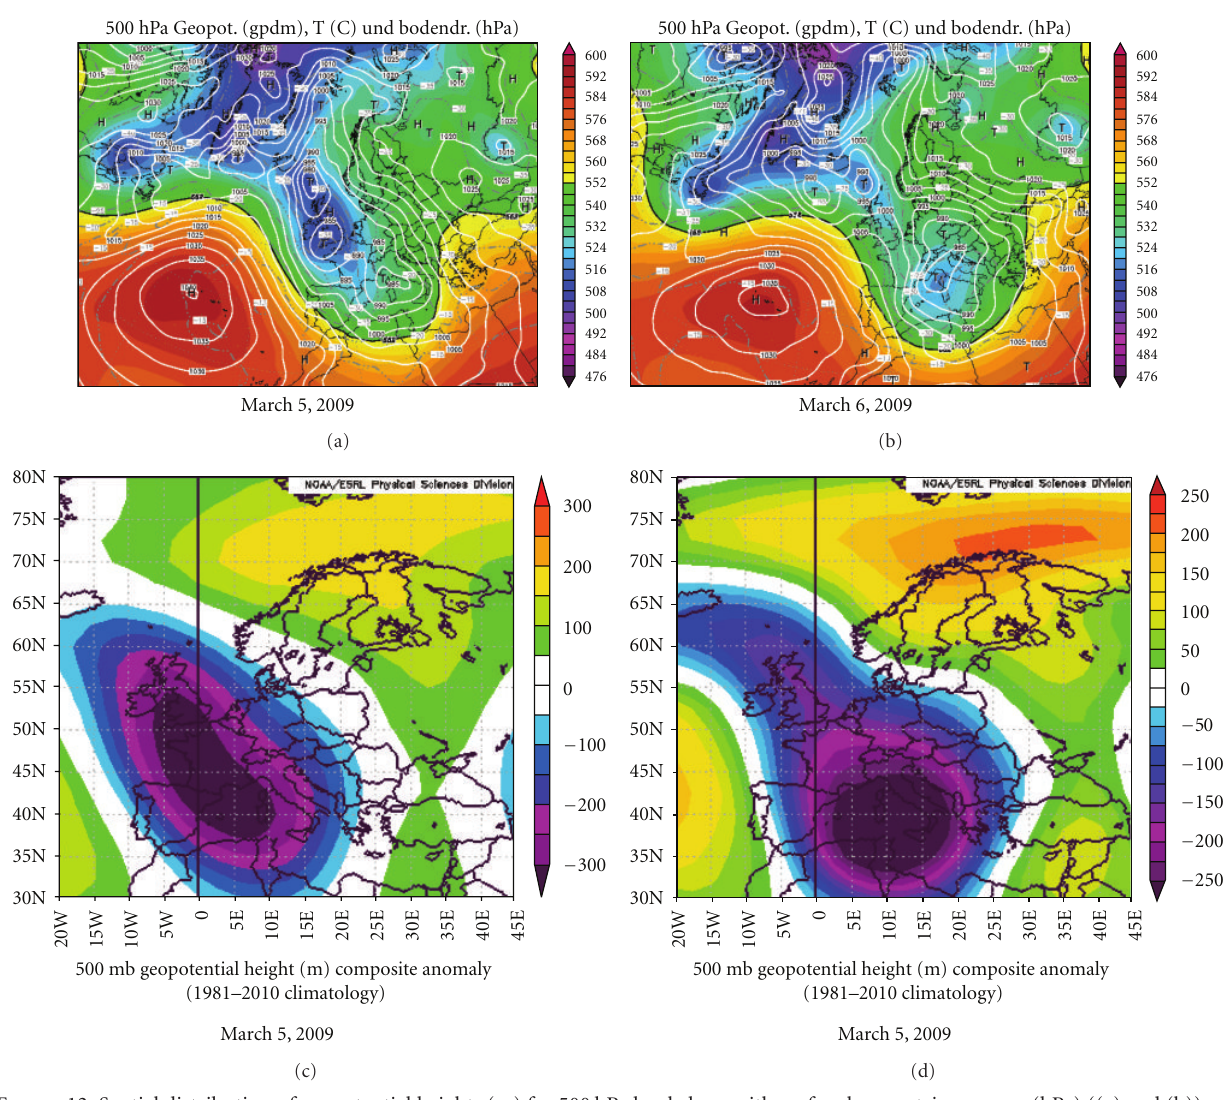
Figure 12: Spatial distribution of geopotential heights (m) for 500hPa level along with surface barometric pressure (hPa) ((a) and (b)) and composite anomaly from 1981–2010 Climatology of the geopotential heights (m) at 500 hPa level ((c) and (d)) during the Saharan episodes on March 5, 2009 ((a) and (c)) and March 6, 2009 ((b) and (d)), using NCEP/NCAR reanalysis